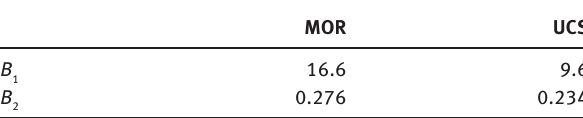
Table 1 Coefficients for moisture adjustment of dimension lumber mechanical properties with change in moisture